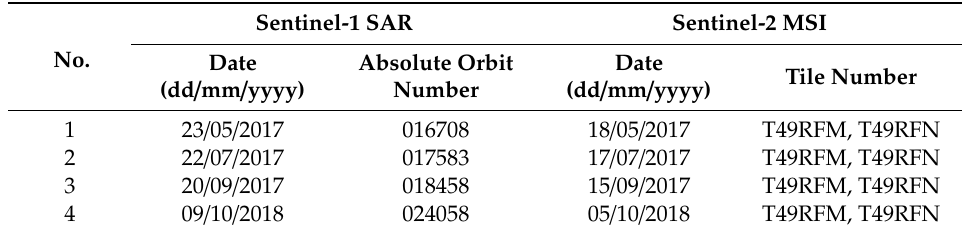
Table 1. The acquisition date and identifier information for the Sentinel-1 synthetic aperture radar (SAR) and Sentinel-2 MSI data used in this study *.